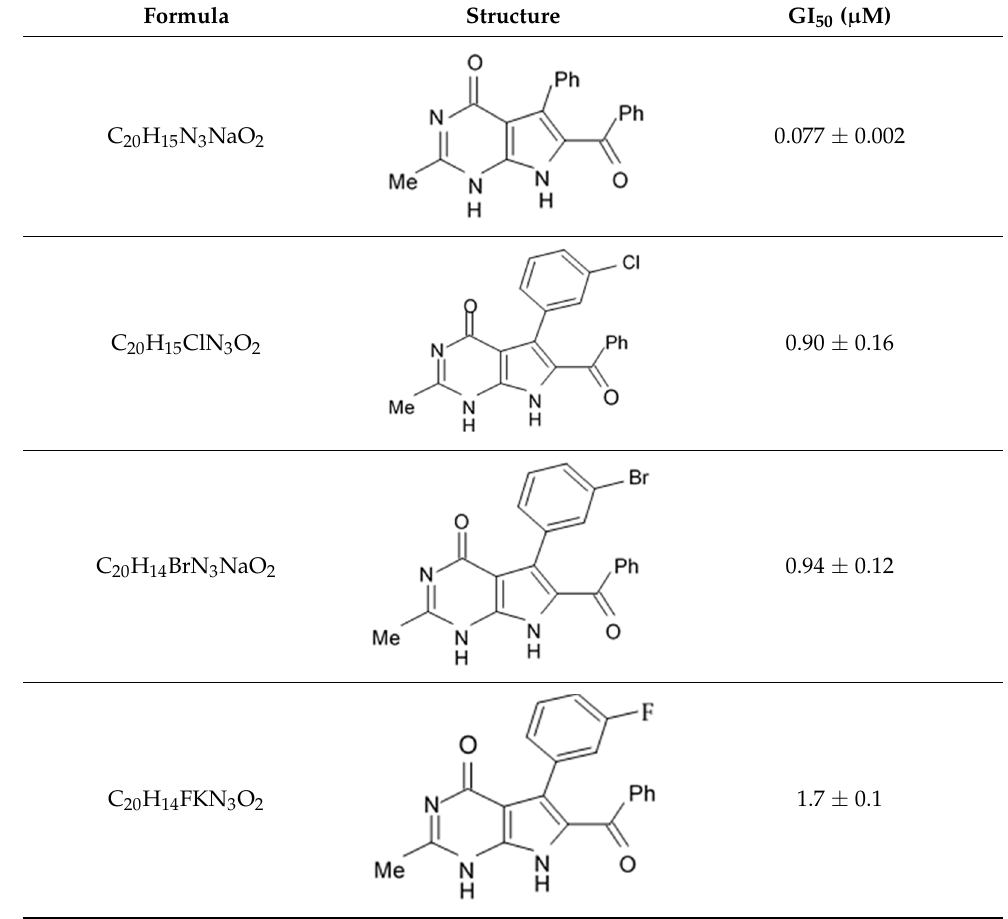
Table 6. Structure and antiproliferative activities of C2-methyl-7-deazahypoxanthines against U-87 glioma cells [79].